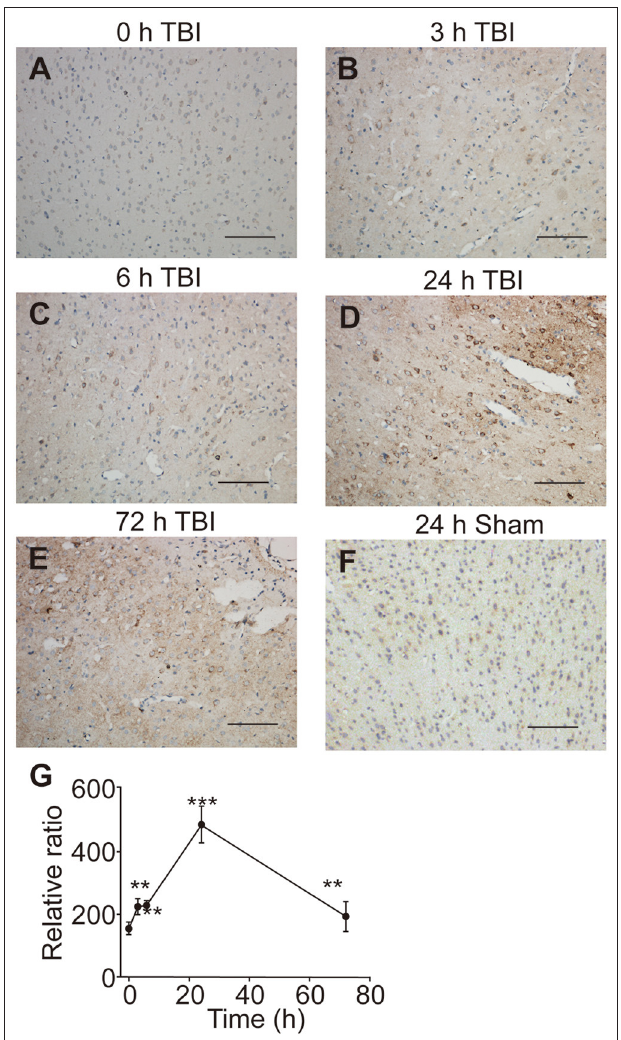
FIGURE 7 | UT-B expression before and after traumatic injury detected by immunohistochemistry. (A) Immunohistochemistry of UT-B in the ipsilateral cortex near the site of before injury. (B–E) Immunohistochemistry of UT-B in the ipsilateral cortex near the site of injury after 3, 6, 24, and 72h. (F) Immunohistochemistry of UT-B of the sham operation group mice in the ipsilateral cortex near the site after 24h. (G) The tendency of UT-B level analyzed by Image-pro Plus. Data presented as mean ± SEM. ** P < 0.01, *** P < 0.001, n = 6. UT-B, urea transporter